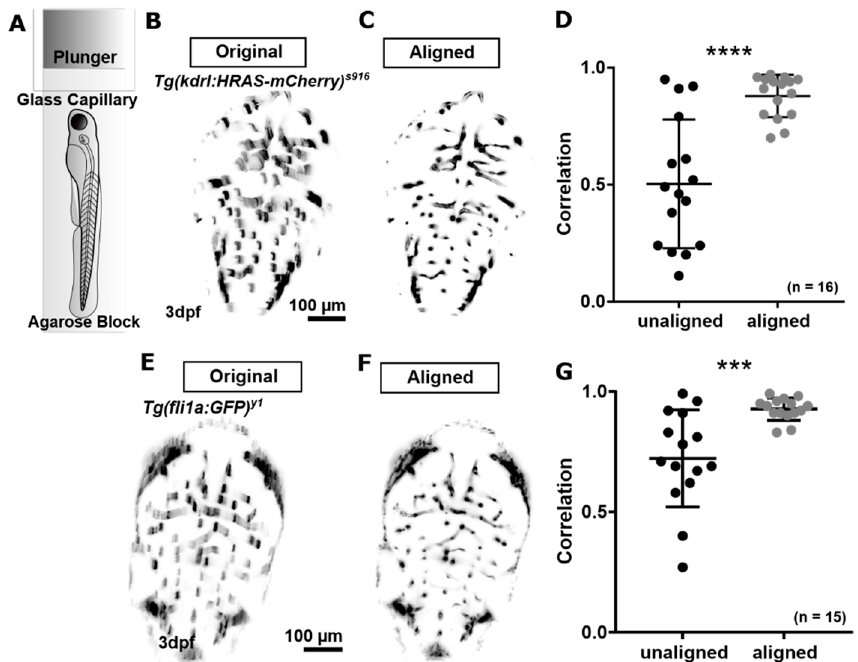
Figure 3. ( A ) Samples were embedded in an agarose block for LSFM. ( B – D ) Motion correction for the transgenic Tg(kdrl:HRAS-mCherry) s916 was previously tested [13]. ( E , F ) Application of the same motion correction approach to the transgenic Tg(fli1a:eGFP) y1 delivered a similar level of artefact correction ( p 0.0008; ***). Figure ( D) reproduced with permission from [13] under licence 4466480468142.